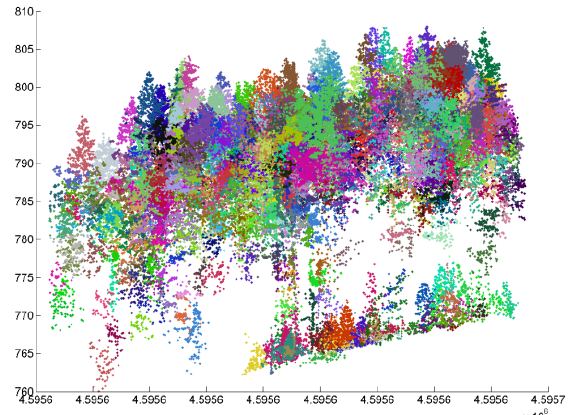
Figure 4 Mean shift clusters of an exemplary sample plot